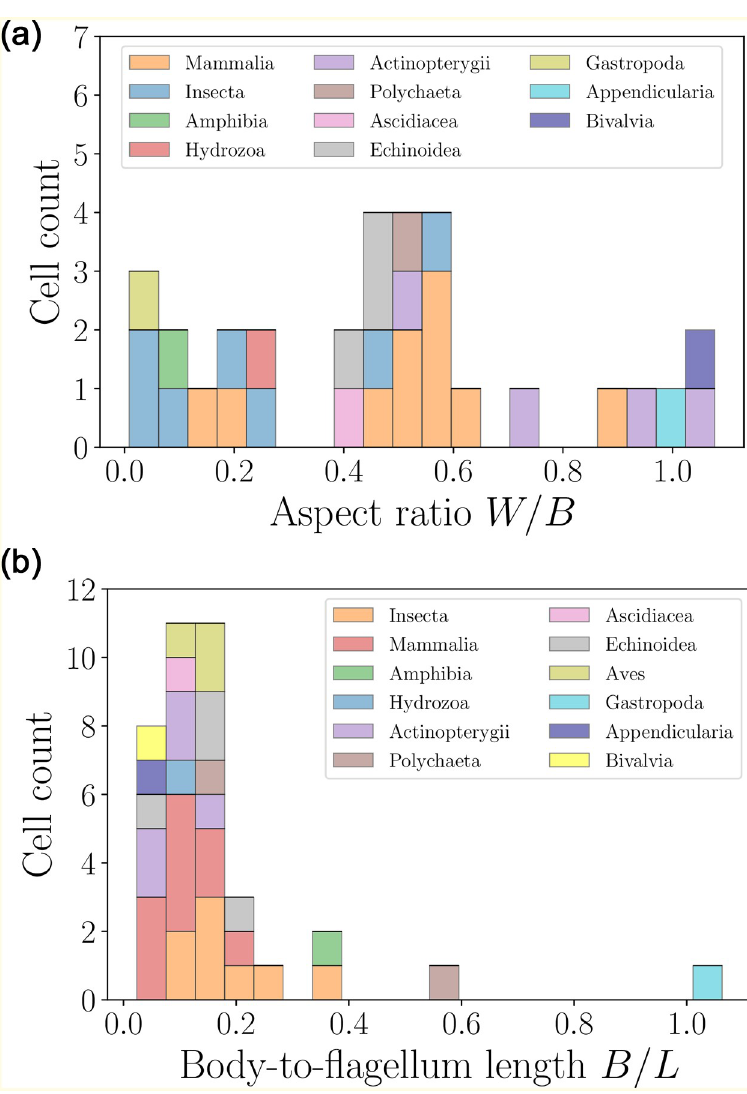
Fig 15. Histograms of aspect ratios W / B (left) and body-to-flagellum length B / L (right) for spermatozoa (colours mark the different taxonomic classes). The distribution of cell aspect ratios is rather wide, and yields an average value of h W / B i = 0.47 ± 0.30 ( n = 31). The size-to-flagellum length ratios are mostly close to the average h B / L i = 0.17 ± 0.18 ( n = 38), showing that in spermatozoa the flagellum length is typically much larger than the cell body.